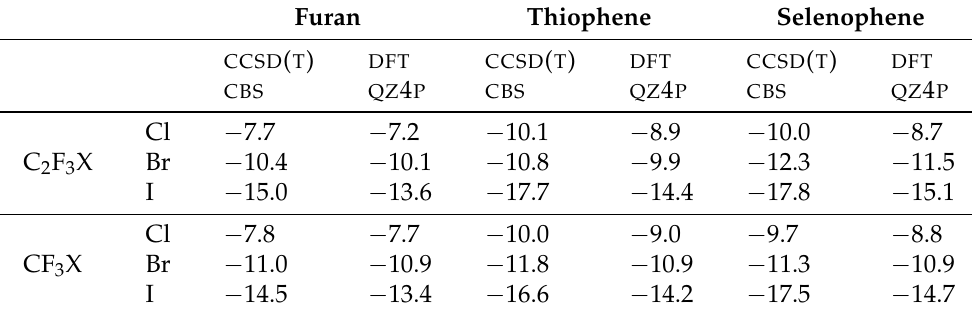
Table 2. Interaction energies (kJ/mol) for the perpendicular oriented complexes calculated with